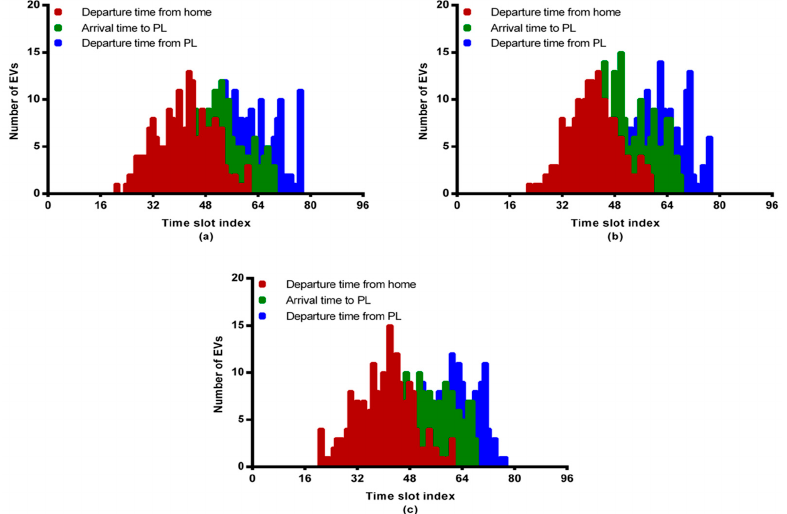
Figure 9. Random distribution of arrival and departure times of EVs for the PLs connected to the three buses: ( a ) Represent the PL at bus #820; ( b ) Represent the PL at bus #834; ( c ) Represent the PL at bus #844.